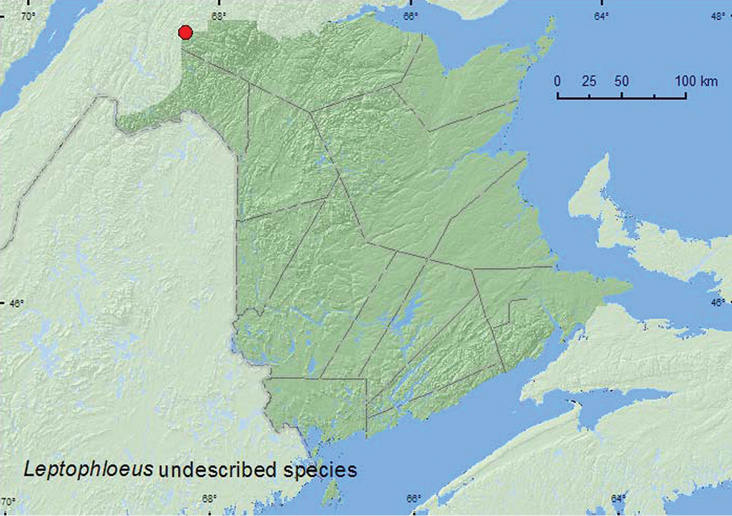
Collection localities in New Brunswick, Canada of Leptophloeus undescribed species.